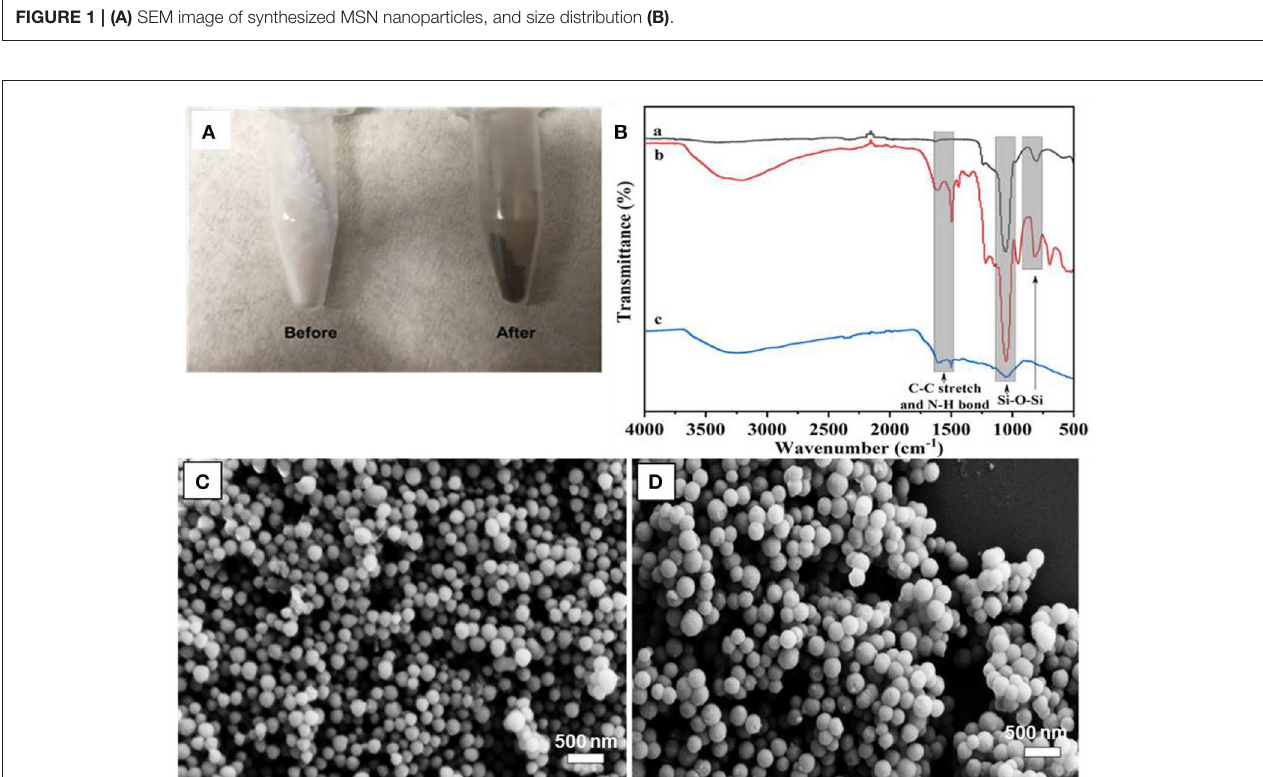
FIGURE 2 | (A) Photo images of MSN before and after PDA coating, (B) FT-IR spectra of MSN (a), MSN@PDA (b) and MSN@PDA after 48h water dispersion (c), and SEM image of (C) MSN@PDA particles after 18 h-PDA coating at 25 ◦ C and (D) MSN@PDA particles after 24h-PDA coating at 45 ◦ C.